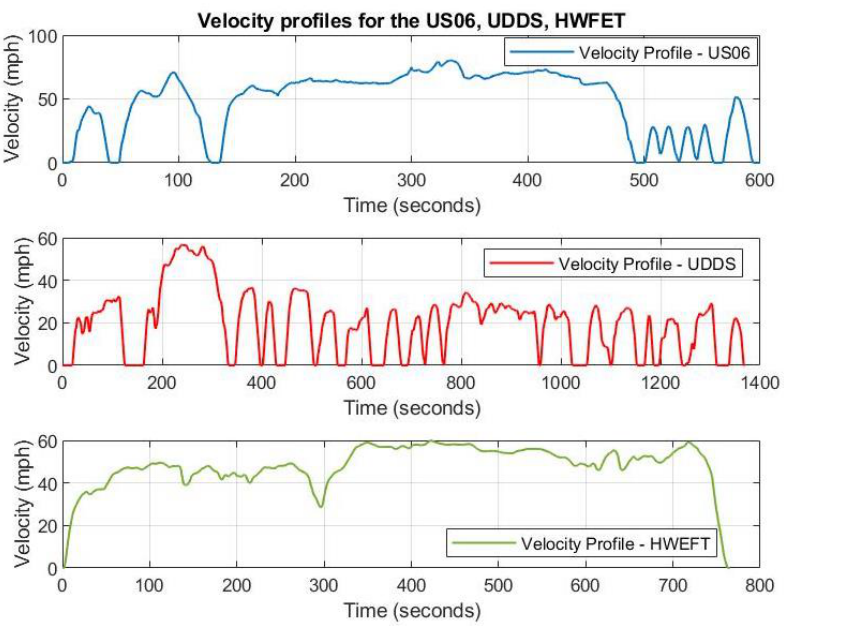
Figure 5. Velocity profiles for the UDDS, US06, and HWFET driving cycles (Data set from [51]).